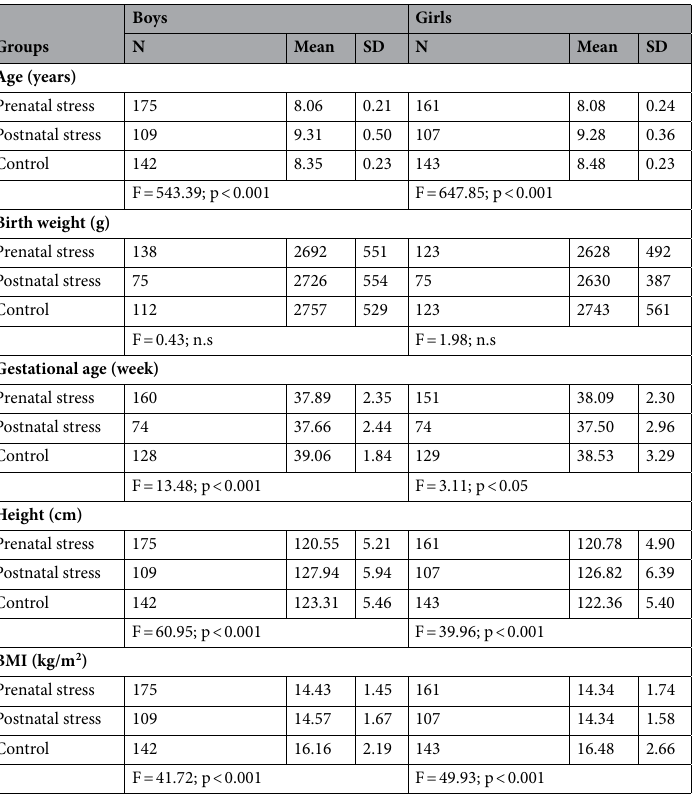
Table 1. Descriptive statistics of age, birth weight, gestational age, height and BMI by experimental groups and controls in boys and girls. Differences in groups were assessed by one-way analysis of